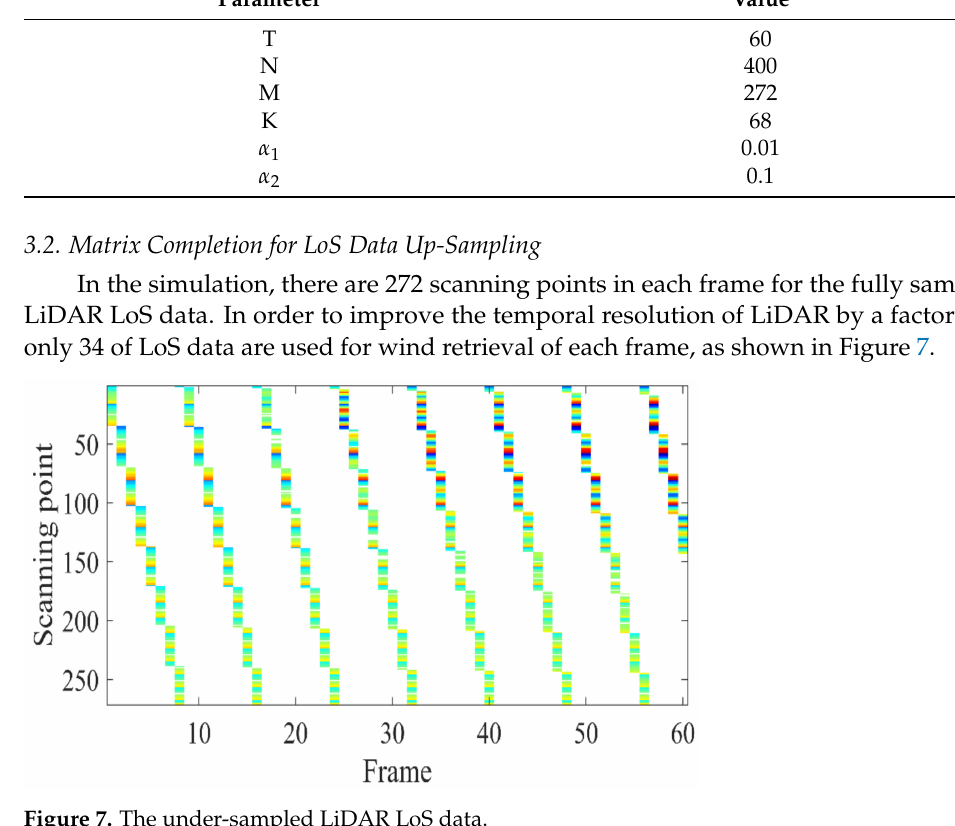
Figure 7. The under-sampled LiDAR LoS